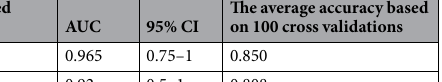
The average accuracy based on 100 cross validations